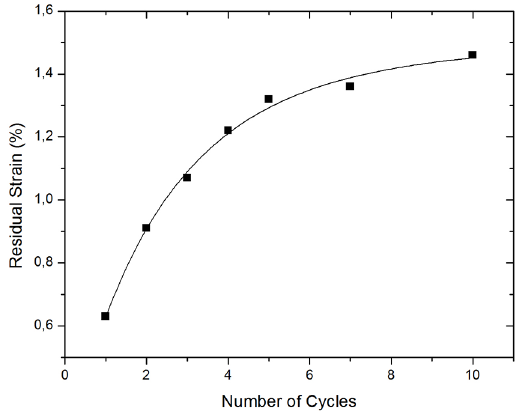
Figure 8. Residual strain as a function of the number of cycles for alloy Cu-11.8Al-0.6Be-0.5Nb (wt.%) at a temperature of 25 ºC.